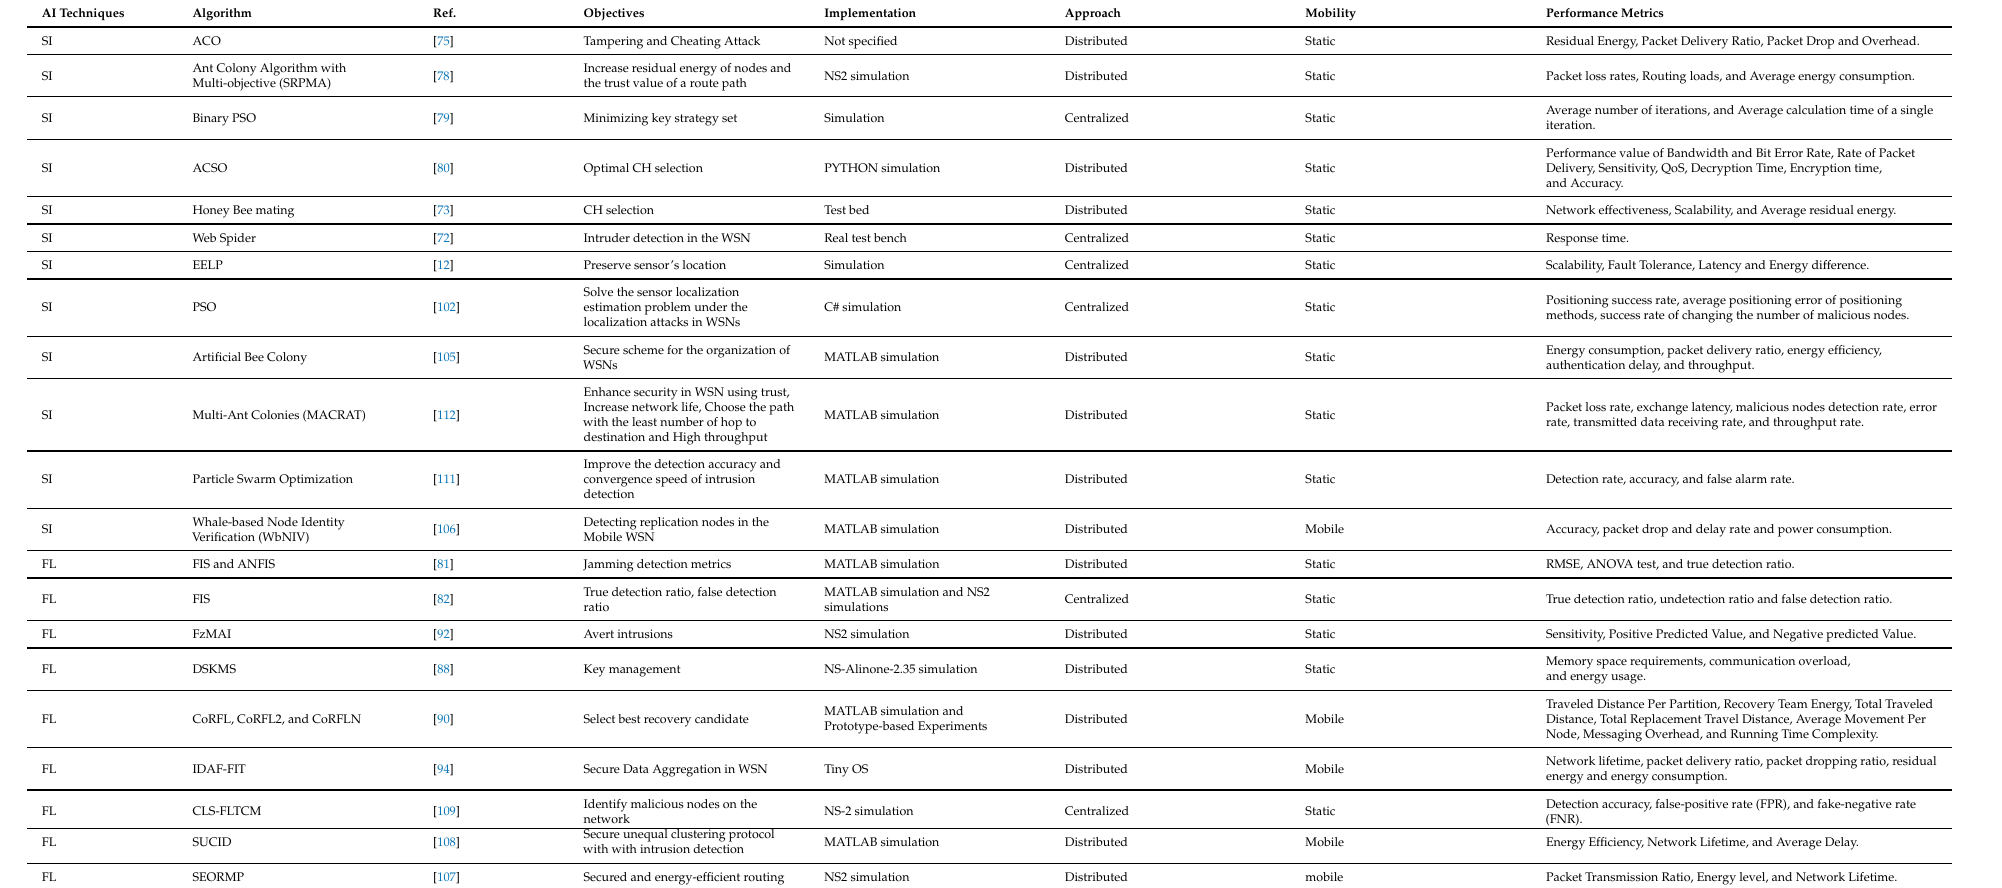
Table 3. Summary of AI-based solutions to WSN security problems discussed in Section